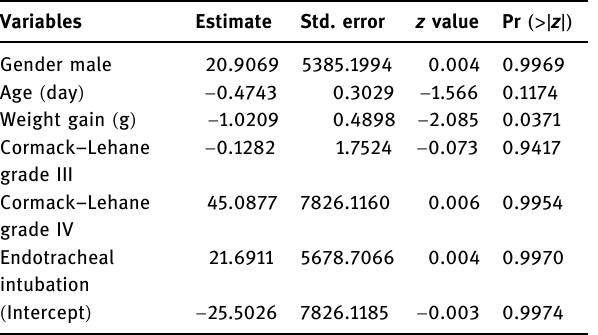
Table 4: Comparison of performances of single variables